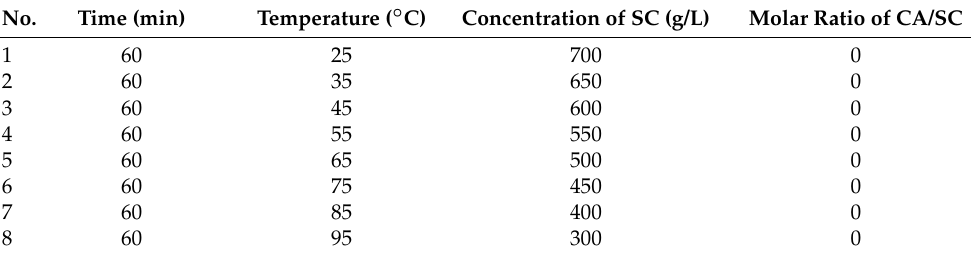
Table 1. Optimal leaching conditions for PbSO 4 in CA/SC solutions.